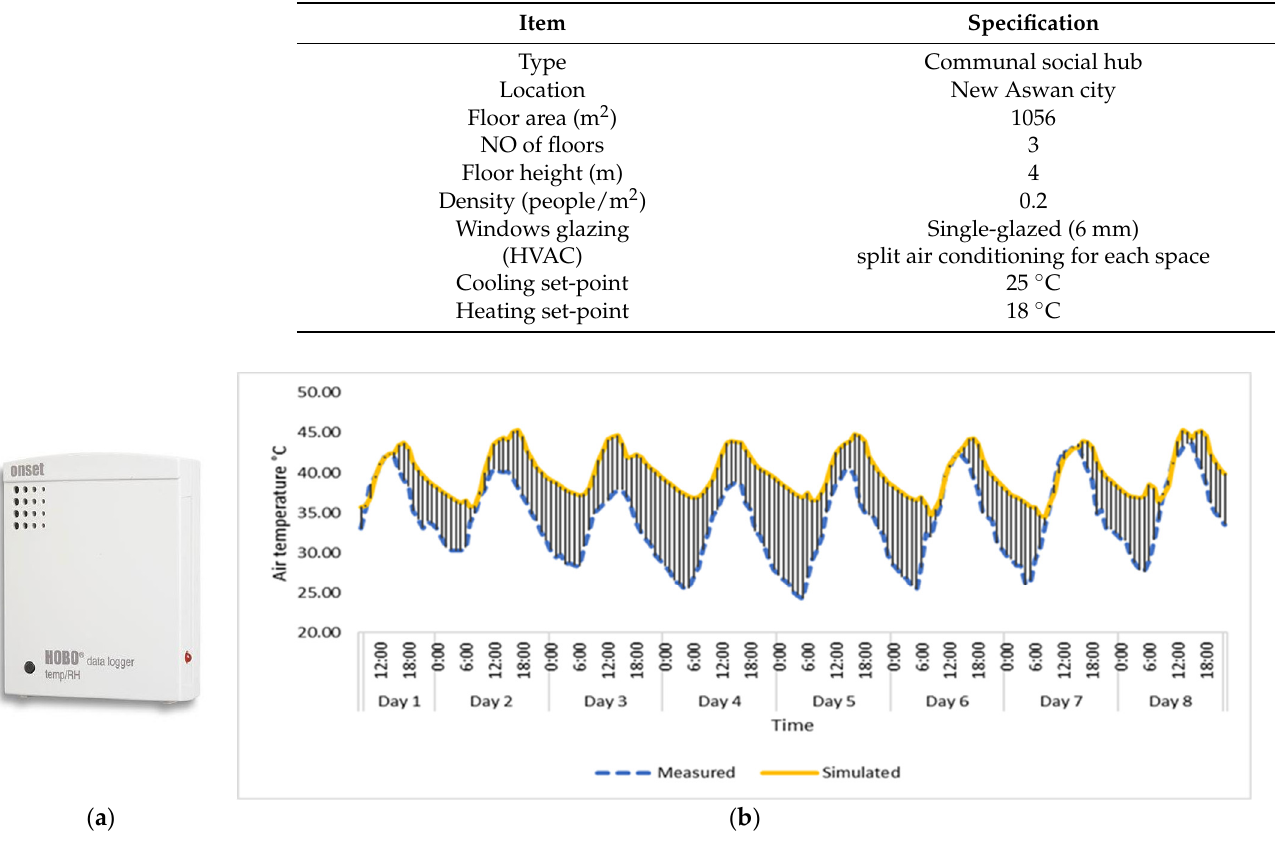
Figure 4. The validation process for the model: ( a ) the weather station at Aswan University (Hobo U30), ( b ) the plotted results for the measured and simulated data. Table 1. The simulation input data and assumptions of the study model.